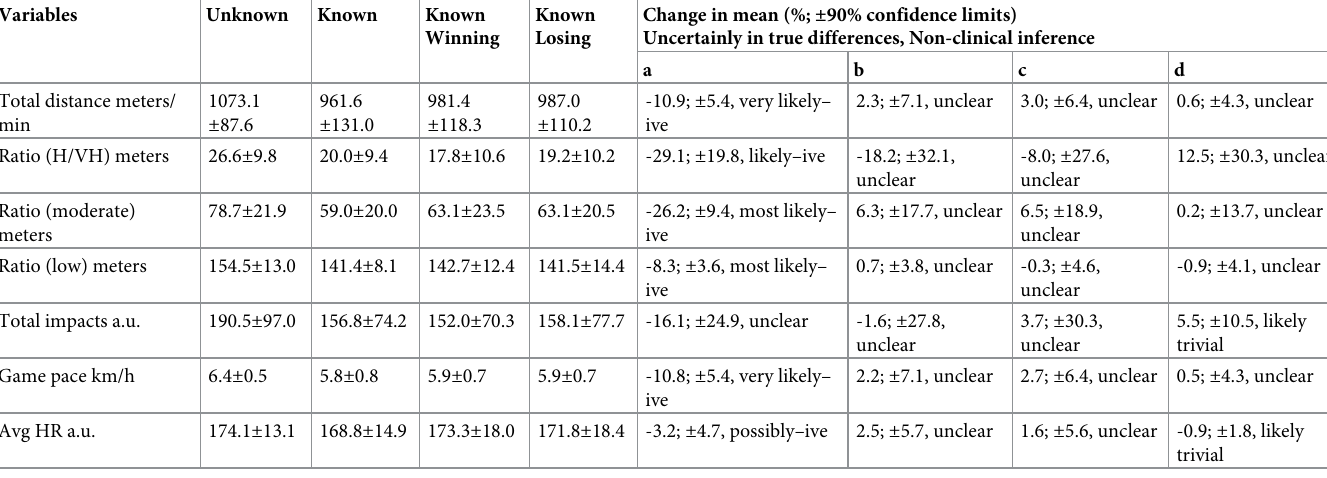
Table 1. Descriptive statistics on the different condition